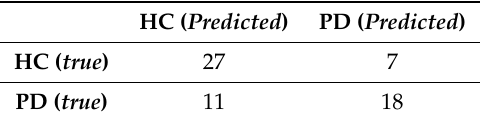
Table 4. Confusion matrix for the RF